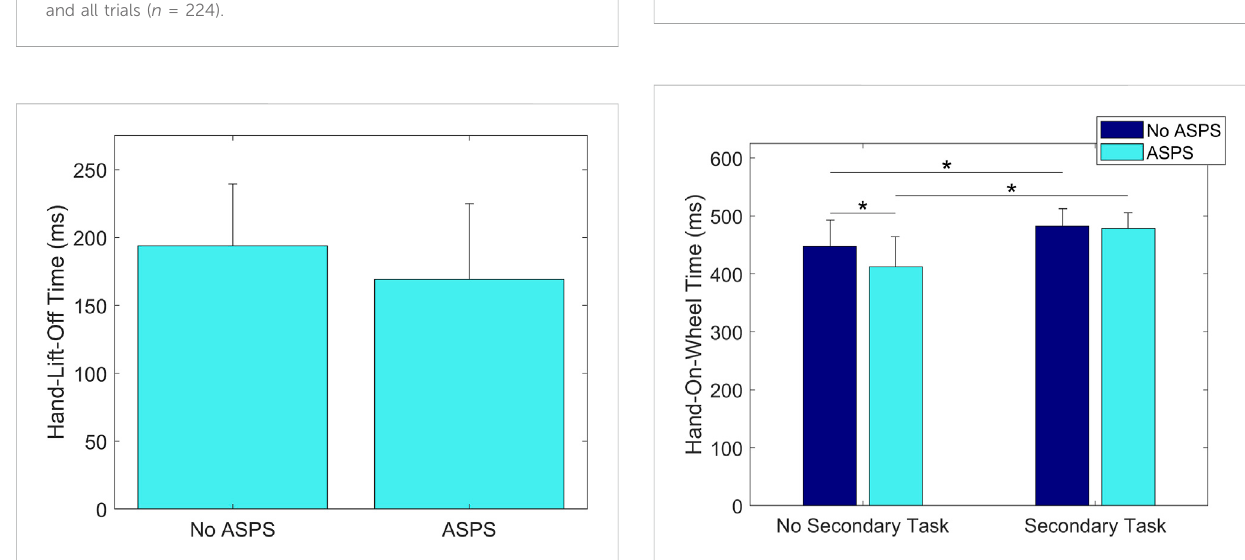
Group means ± SD for Hand-On-Wheel Time without and with the ASPS for adult drivers and teenage drivers.